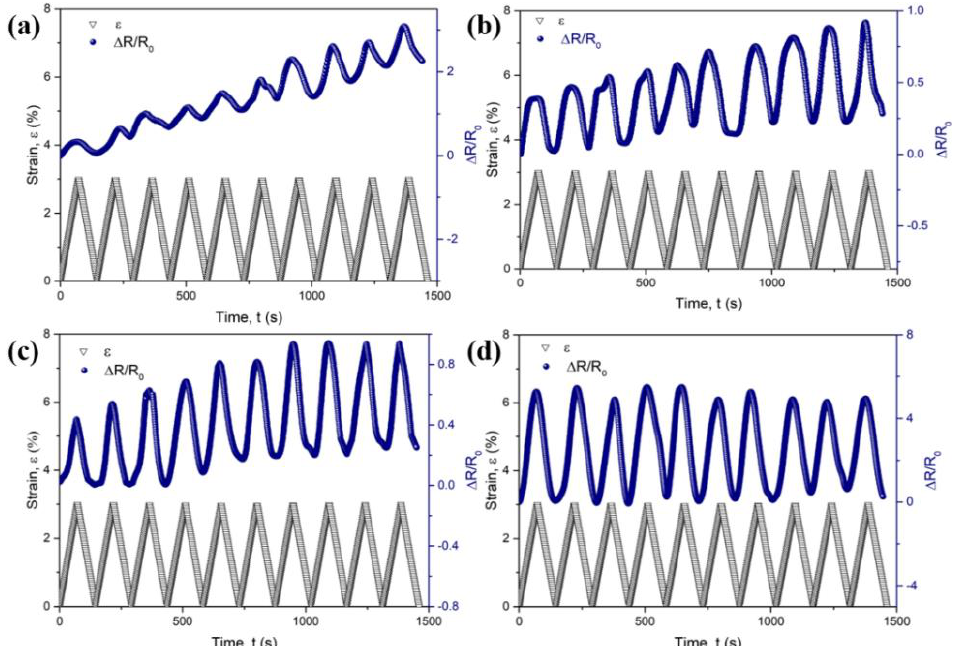
Figure 7. The variations of strain and ΔR/R 0 with time for CB/PA6/PP composites: ( a ) λ = 1, ( b ) λ = 5, ( c ) λ = 10, ( d ) λ = 15 in ten times extension – retraction cycles.